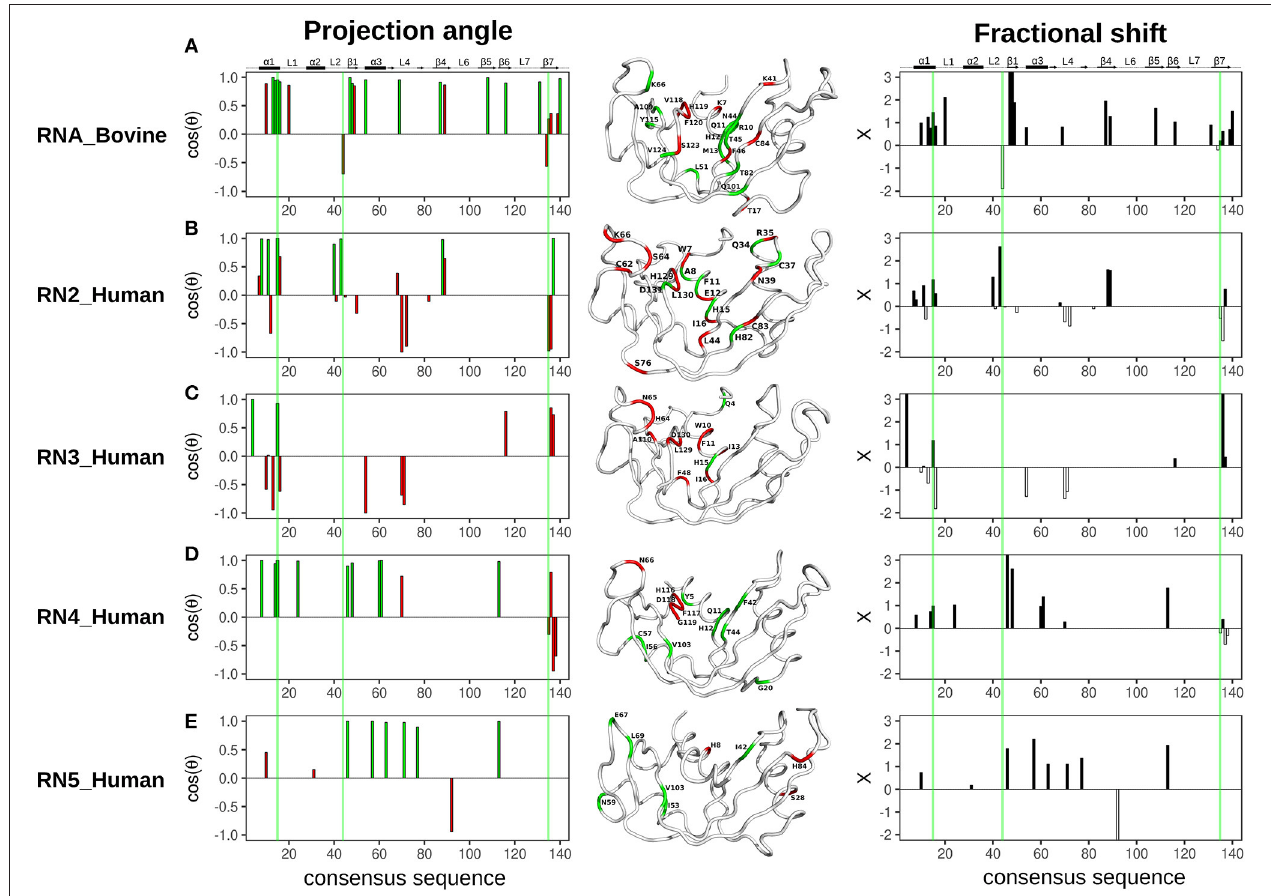
FIGURE 5 | Chemical shift projection analysis of 3 ′ -UMP and 5 ′ -AMP ligand binding to functionally distinct RNases. The projection angle (cos( θ ), left) and the fractional shift (X, right), calculated for residues with 1 δ obs > 0.05 ppm at the highest ligand concentration, are plotted as a function of consensus sequence for bovine RNase A and human RNases 2–5 upon binding of 3 ′ -UMP and 5 ′ -AMP single nucleotide RNA ligands. (A–E) Residues showing cos( θ ) ∼ 0.9 are colored green (coordinated), those with cos( θ ) < 0.9 are colored red (uncoordinated). Residues are also identified on the three-dimensional structures of the five RNases using tube representations in the color scheme described above. Fractional shifts as a function of consensus sequence for bovine RNase A and human RNases 2–5, respectively, are shown on the right. Residues displaying positive and negative fractional shifts are displayed using black and white bars, respectively. Active-site residues (His12, Lys41, His119, RNase A numbering) are highlighted using green lines. Secondary structure of bovine RNase A is traced on top of the sequence alignment using blocks, arrows and dashed lines to represent α -helix, β -strand and loop regions,